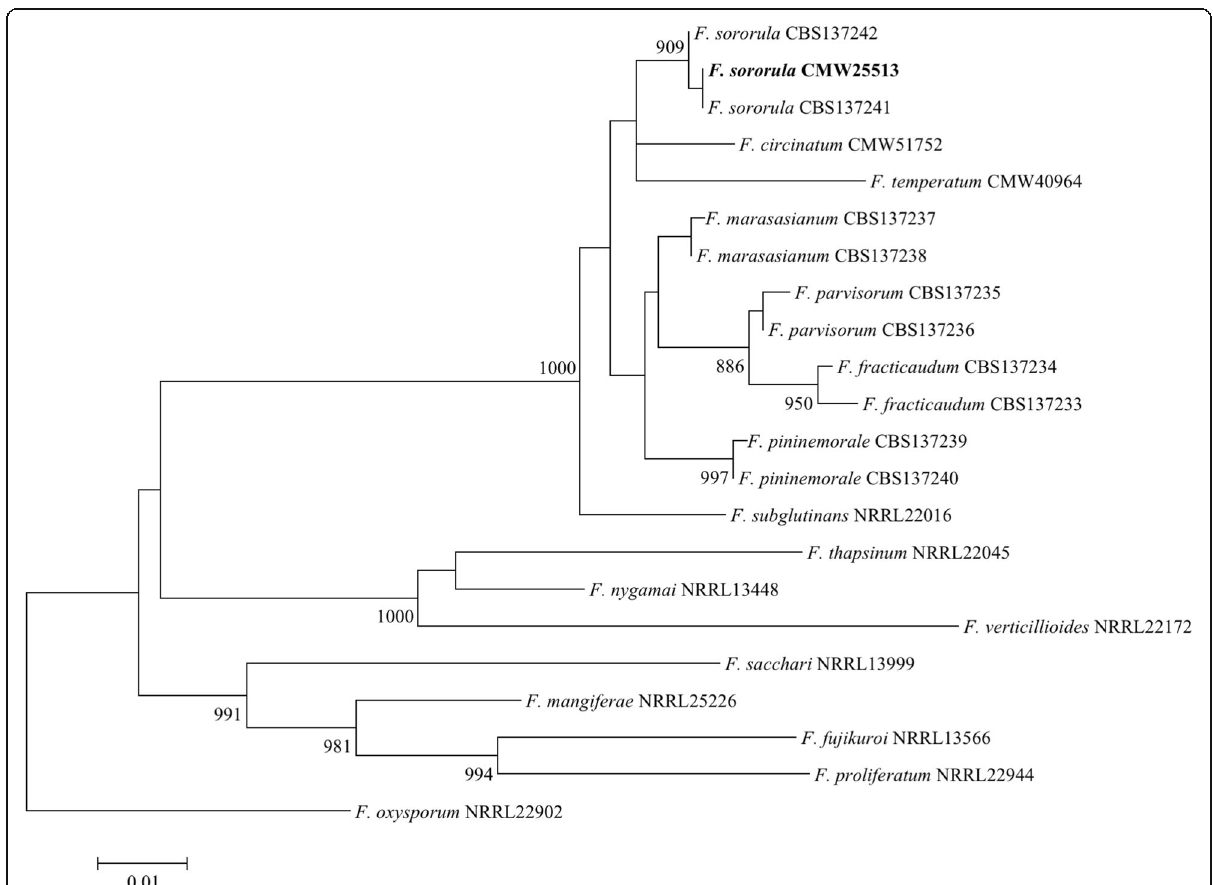
Fig. 2 Maximum Likelihood tree based on the partial gene sequences of translation elongation factor 1- α and β -tubulin (Herron et al. 2015). Sequence alignments were assembled with MAFFT v 7.472 (Katoh et al. 2019). The program jModelTest v 2.1.10 (Darribo et al. 2012) was used to determine the best-fit substitution model (GTR + I + G substitution model) with gamma correction (Tavare 1986). A maximum Likelihood (ML) phylogenetic analysis was performed using PhyML v 3.1 (Guindon et al. 2010). Values at branch nodes are the bootstrapping confidence values with those ≥ 85% shown. The F. sororula isolate sequenced in this study is indicated in